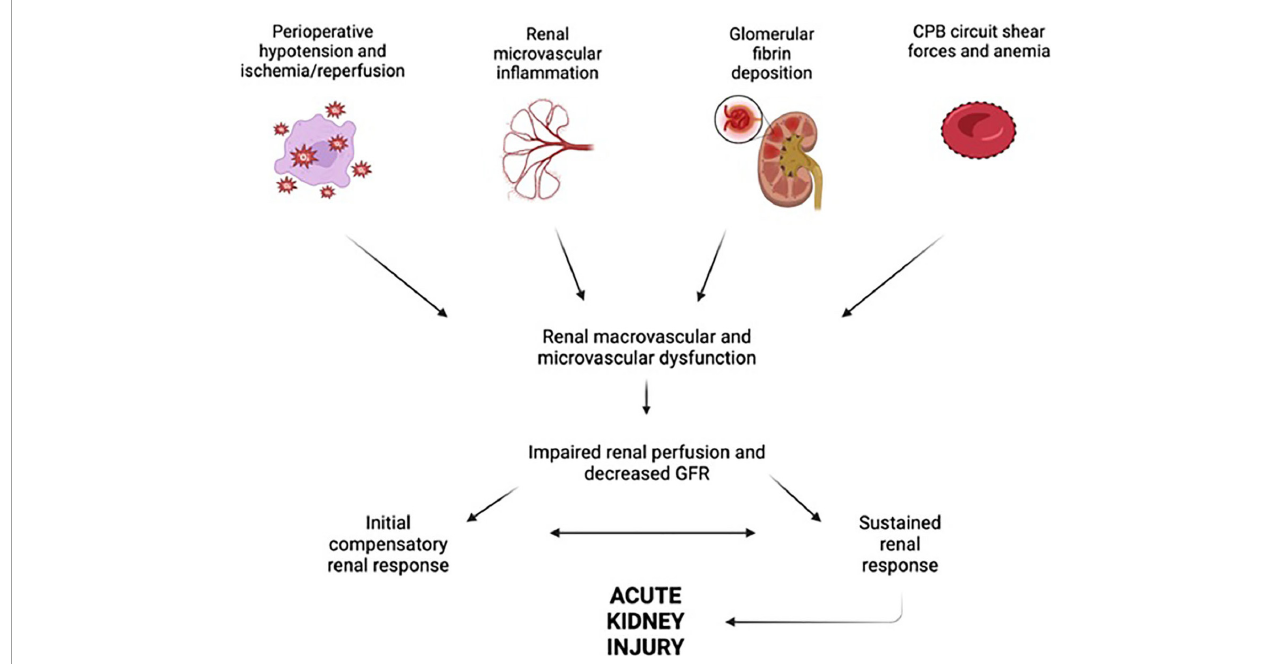
FIGURE3 Factors leading to renal dysfunction during and after cardiopulmonary bypass. Perioperative hypotension, renal microvascular inflammation, glomerular fibrin deposition, and cardiopulmonary bypass (CPB) circuit shear forces all act in concert to impair renal perfusion and glomerular filtration rate (GFR), ultimately leading to acute kidney injury. Figure created using